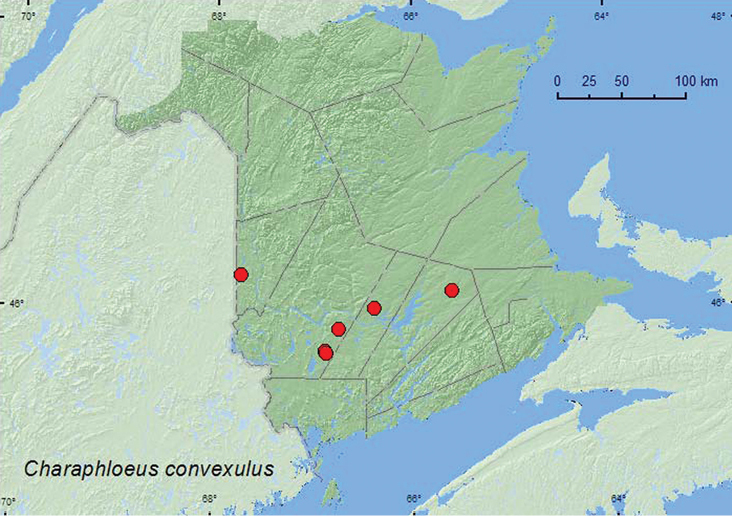
Collection localities in New Brunswick, Canada of Charaphloeus convexulus.